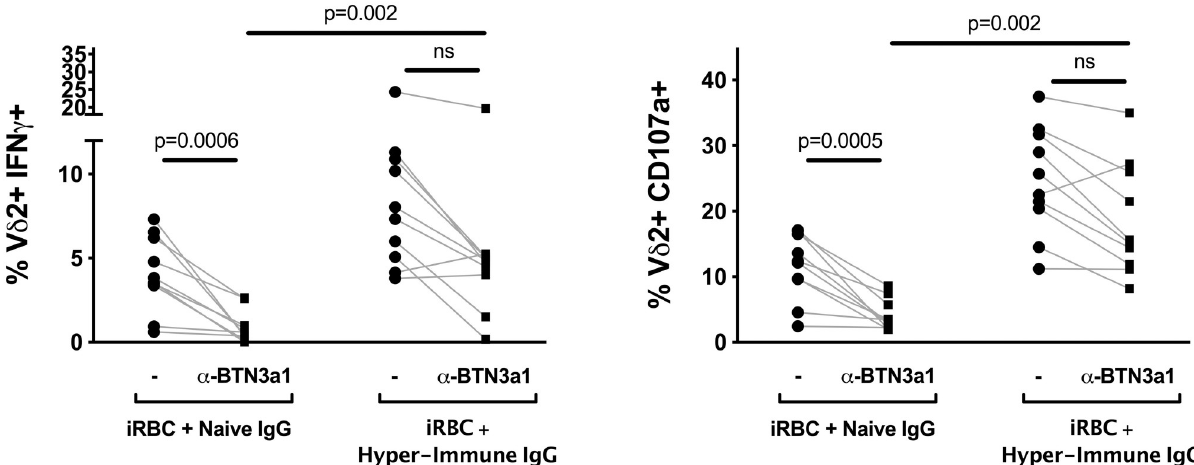
Fig 5. Blocking BTN3a1 does not inhibit stimulation of V δ 2 T cells by opsonized antigen. Percent of V δ 2 T cells positive for IFN γ and CD107a after stimulation with iRBC + na ï ve IgG, or with iRBC + hyper-immune IgG, are compared in the presence or absence of a Butyrophilin 3a1 blocking antibody. (n = 10; p values determined by Wilcoxon matched pairs signed rank test). All V δ 2+ T cells shown were gated on singlets and CD3+ events to exclude NK cells. Samples for this experiment were selected from adults with greater than 30% of their V δ 2s expressing